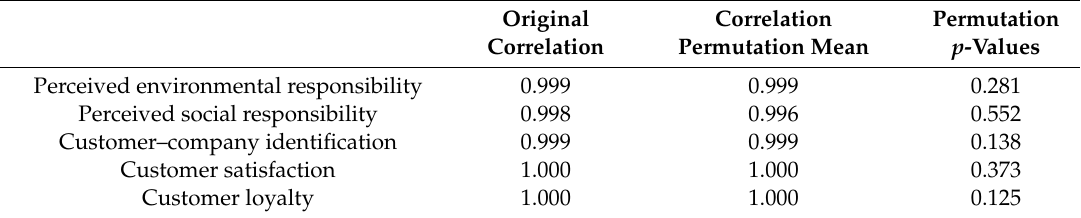
Table 6. Measurement model compositional invariance